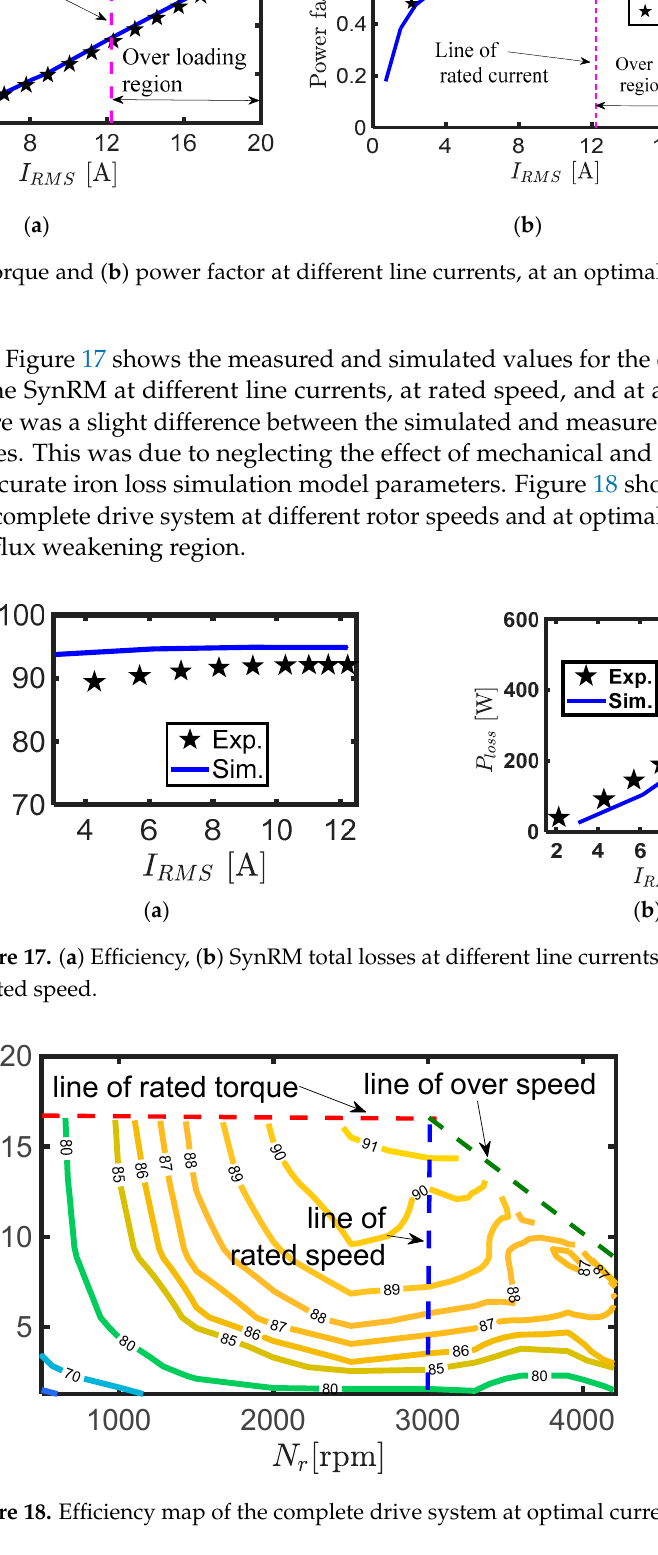
Figure 18. Efficiency map of the complete drive system at optimal current angles.